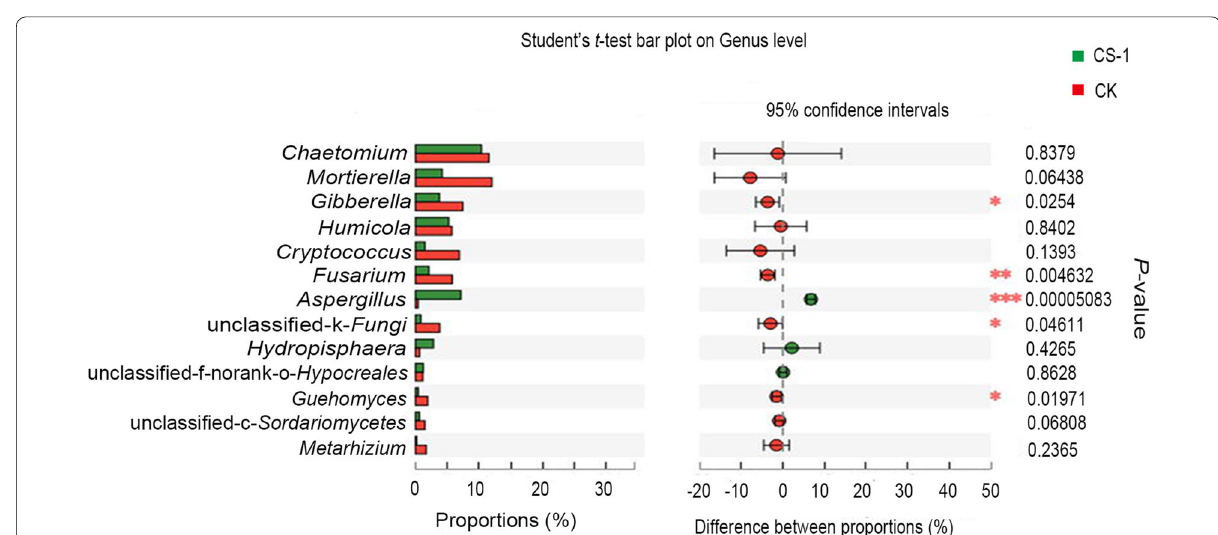
Fig. 6 Multi pathogenic fungal genera difference test between CS-1 and control treatments. Multi-pathogenic fungal genera difference test between CS-1 treatment and control treatments. Error bars indicate standard errors (n ( P < 0.05) according to Student’s t